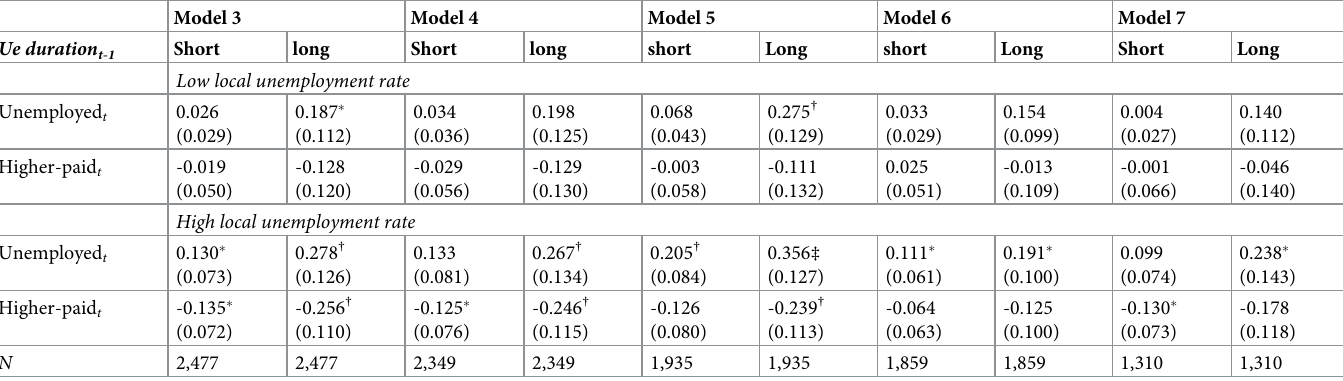
Table 4. Average partial effects of short-term unemployed